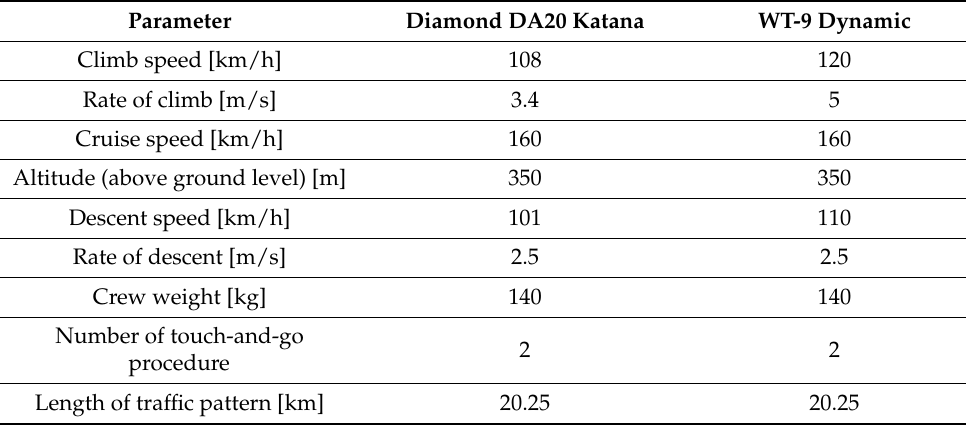
Table 5. Parameters of touch-and-go simulations.